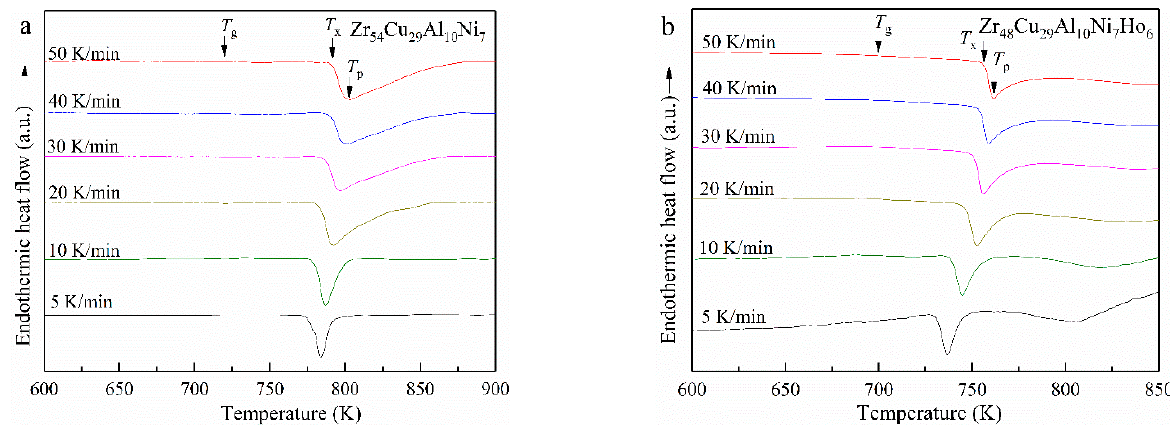
Figure 3. DSC results of Zr54 ( a ) and Zr48Ho6 ( b ) BMGs at various heating rates.